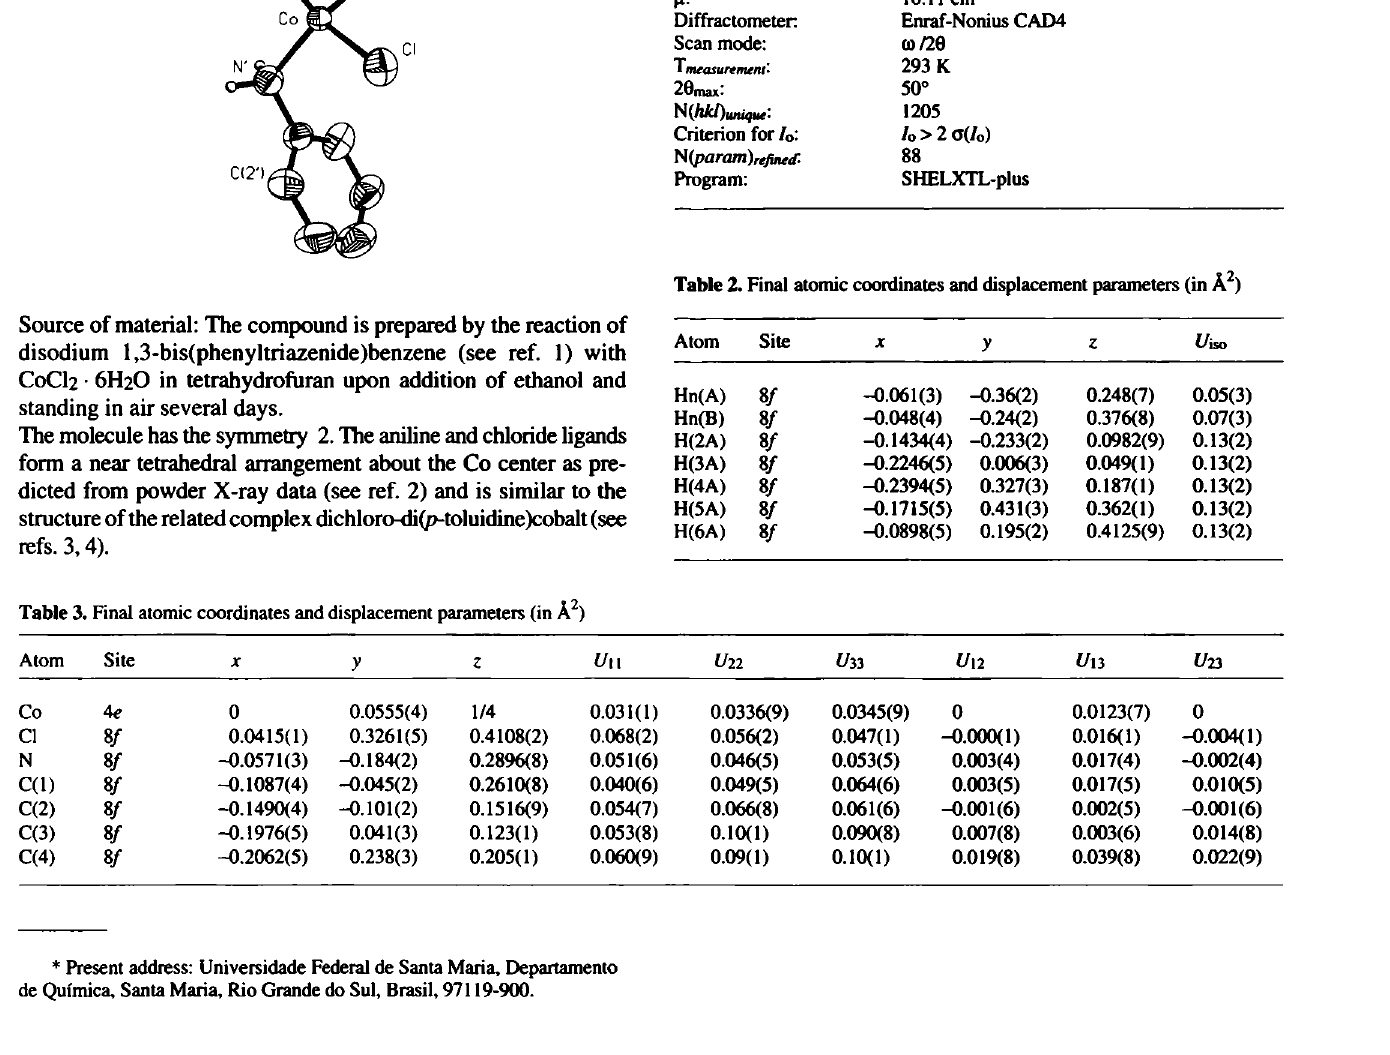
Table 1. Parameters used for the X-ray data collection Crystal: